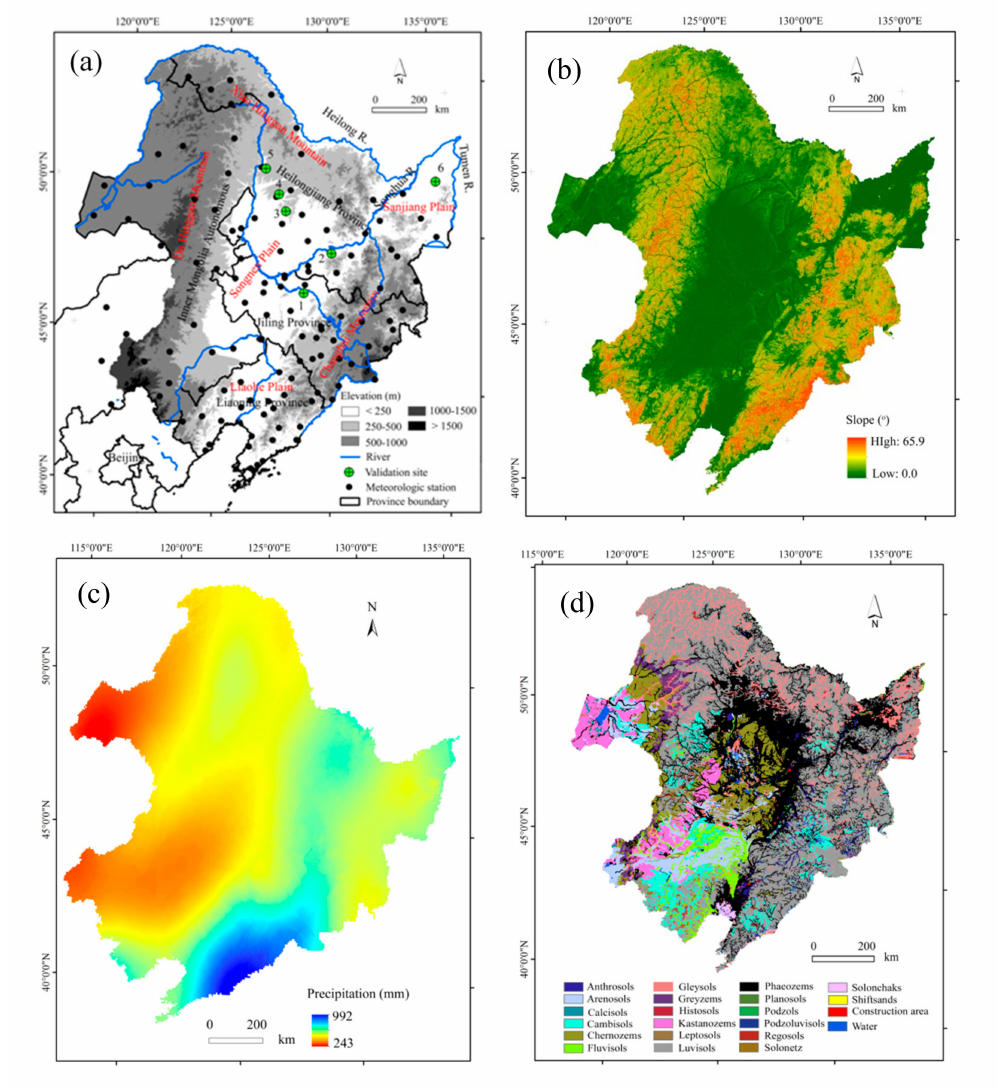
Figure 1. Study area showing the location, topography, meteorological stations, and the validation sites in the current study ( a ), slope gradient distribution ( b ), average annual total precipitation in 1970–2018 ( c ), and soil types ( d ). The numbers in Figure 1a indicate the sites of the published papers used for verifying our results in the current study (1 Dehui County; 2 Binxian County; 3 Baiquan County; 4 Keshan County; 5 Heshan Farmland; 6 Sanjiang Plain). Table 1. The area (100 km 2 ) and percentage (%) of the major crops in the three provinces. HLJ, JL, and LN represent Heilongjiang, Jilin, and Liaoning Provinces. Rice Corn Soybean Wheat Millet Sorghum Tuber